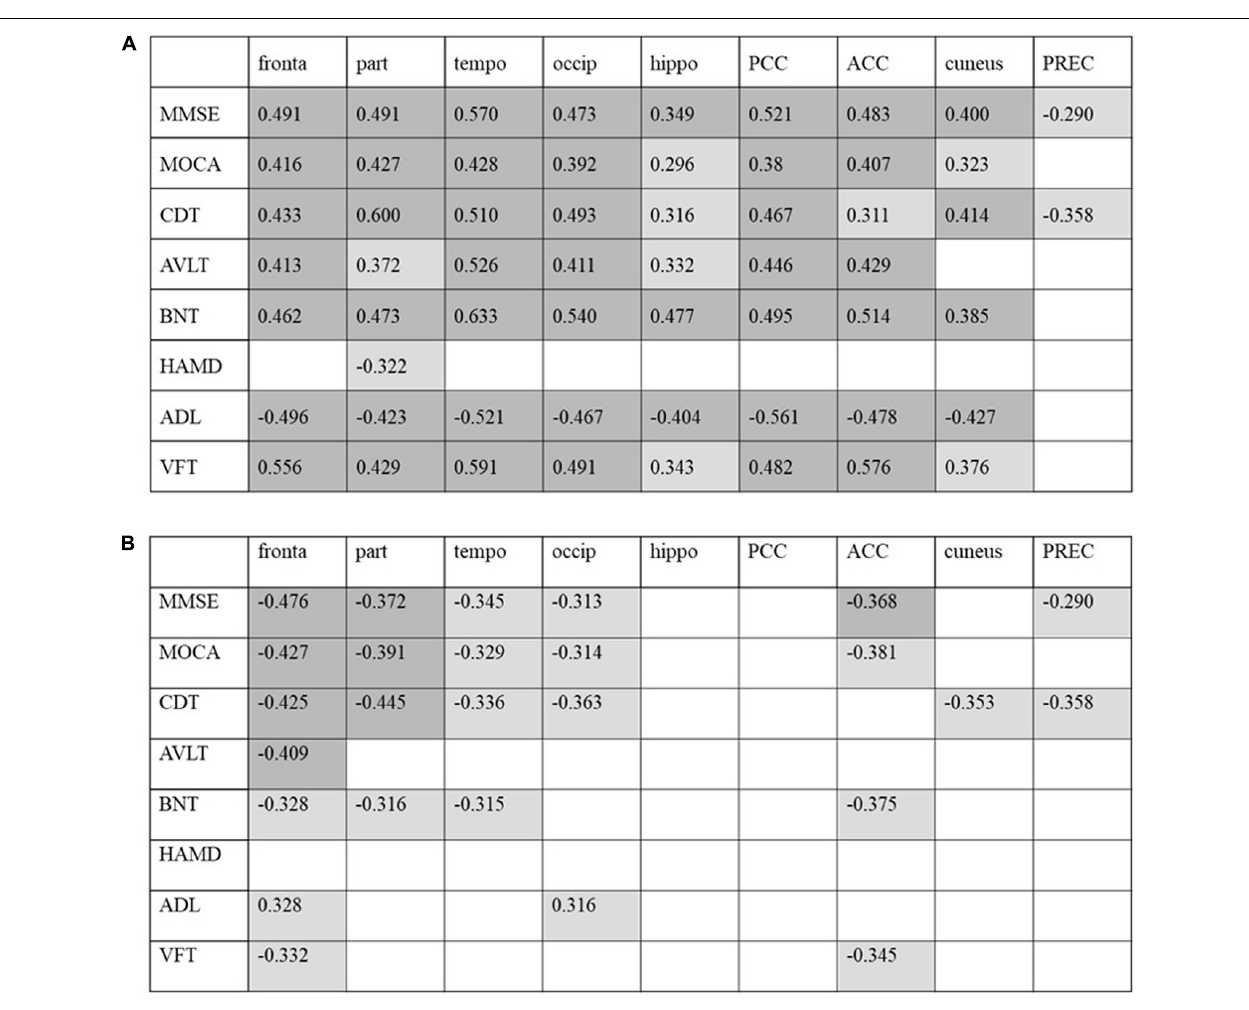
FIGURE 5 | Correlation between cognitive scores with regional FDG-PET SUVR (A) and tau-PET SUVR (B) in patients with AD. Correlation coefficients with p < 0.05 are shaded in light gray, and results with p < 0.01 are shaded in dark gray. PCC, posterior cingulate cortex; ACC, anterior cingulate cortex; PREC, precuneus.